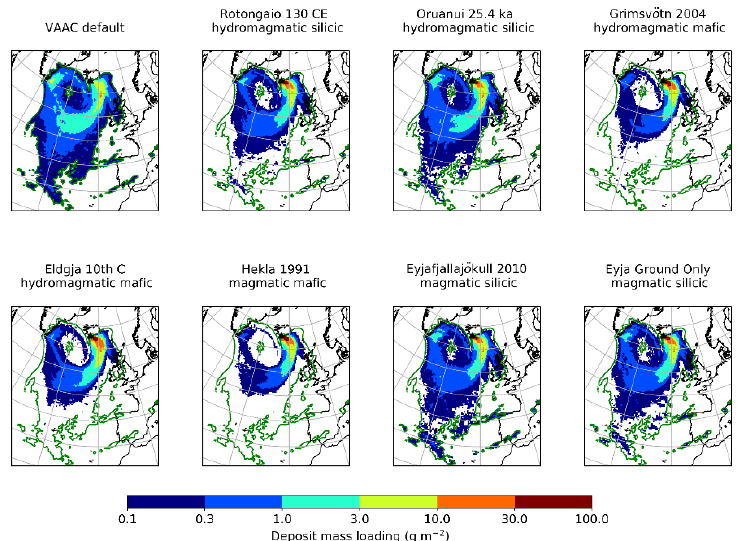
Figure 12. Deposition for the period 4–12 May 2010 using a range of input PSDs. The extent of the simulated deposit using the VAAC default PSD is shown as a green outline on each plot.